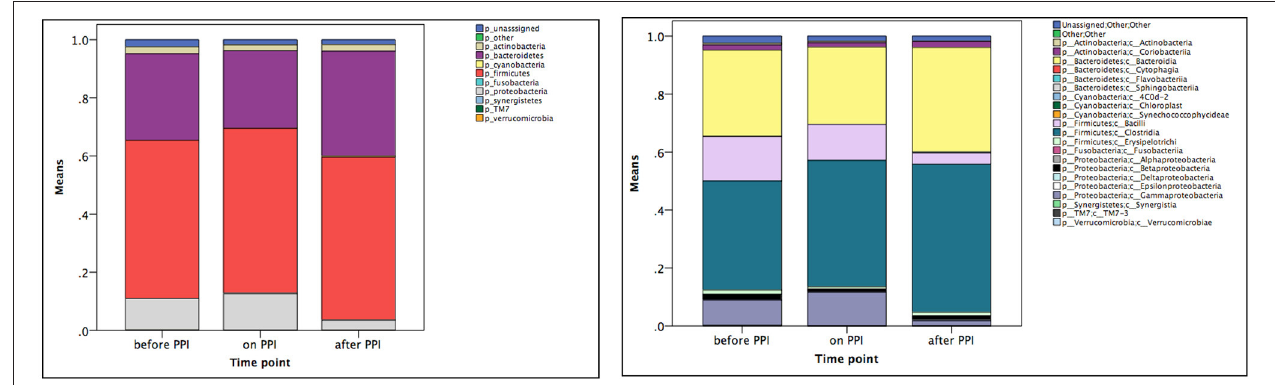
FIGURE 2 | Mean taxa summary plots at the phylum (left panel) and class (right panel) level at the three different time points measured ( n = 12 per time point).